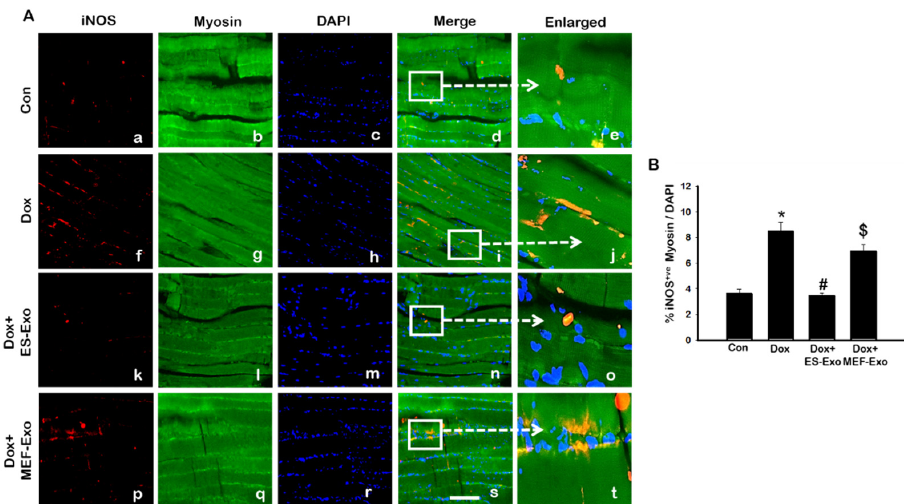
Figure 10. Treatment with ES-Exos reduces pro-inflammatory M1 macrophage abundance following Dox administration. ( A ) Representative photomicrographs of soleus muscle sections stained with myosin and M1 macrophage marker, iNOS. Each box shows iNOS + cells in red ( a , f , k , p ), myocytes in green ( b , g , l , q ), DAPI in blue ( c , h , m , r ), merged images ( d , i , n , s ), and enlarged areas of merged images ( e , j , o , t ). ( B ) Histograms from quantitative analysis of iNOS + cells over total DAPI. Error bars = mean ± S.E.M. * p < 0.05 vs. control, # p < 0.05 vs. Dox, $ p = non-significant vs. Dox, one-way ANOVA followed by Tukey test; Scale bar = 100 µm, n = 14–16, male and female. Images taken at 40 × magnification.